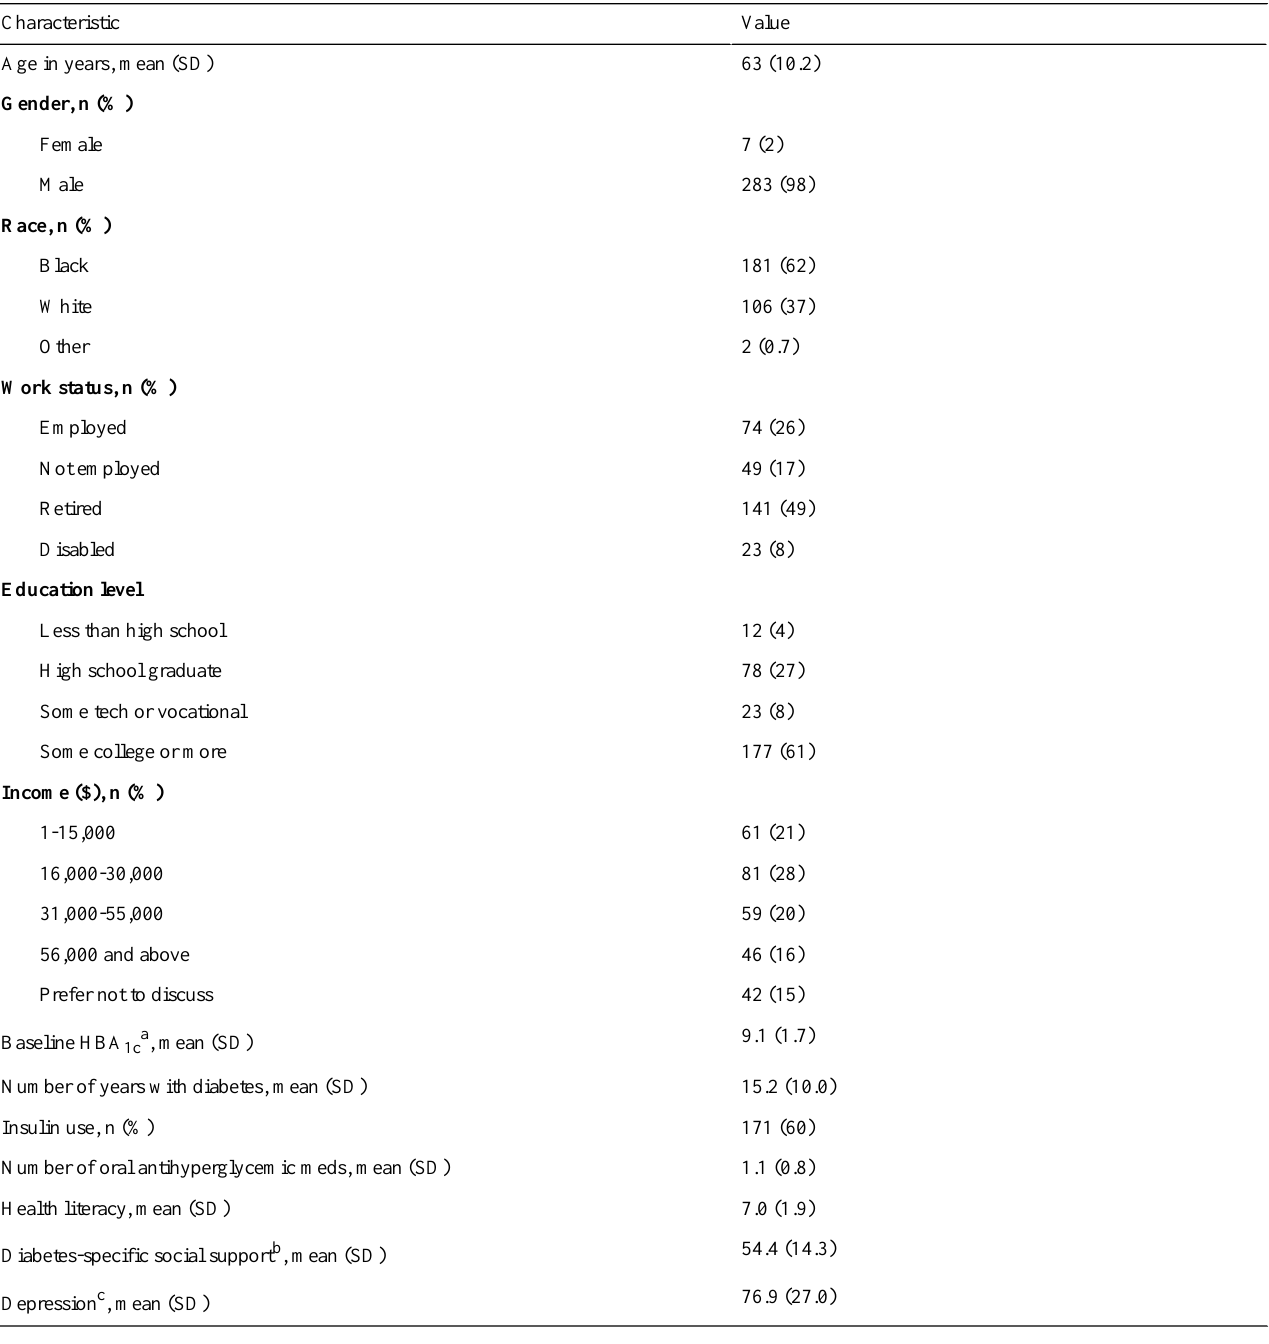
Table 1. Baseline characteristics of all participants